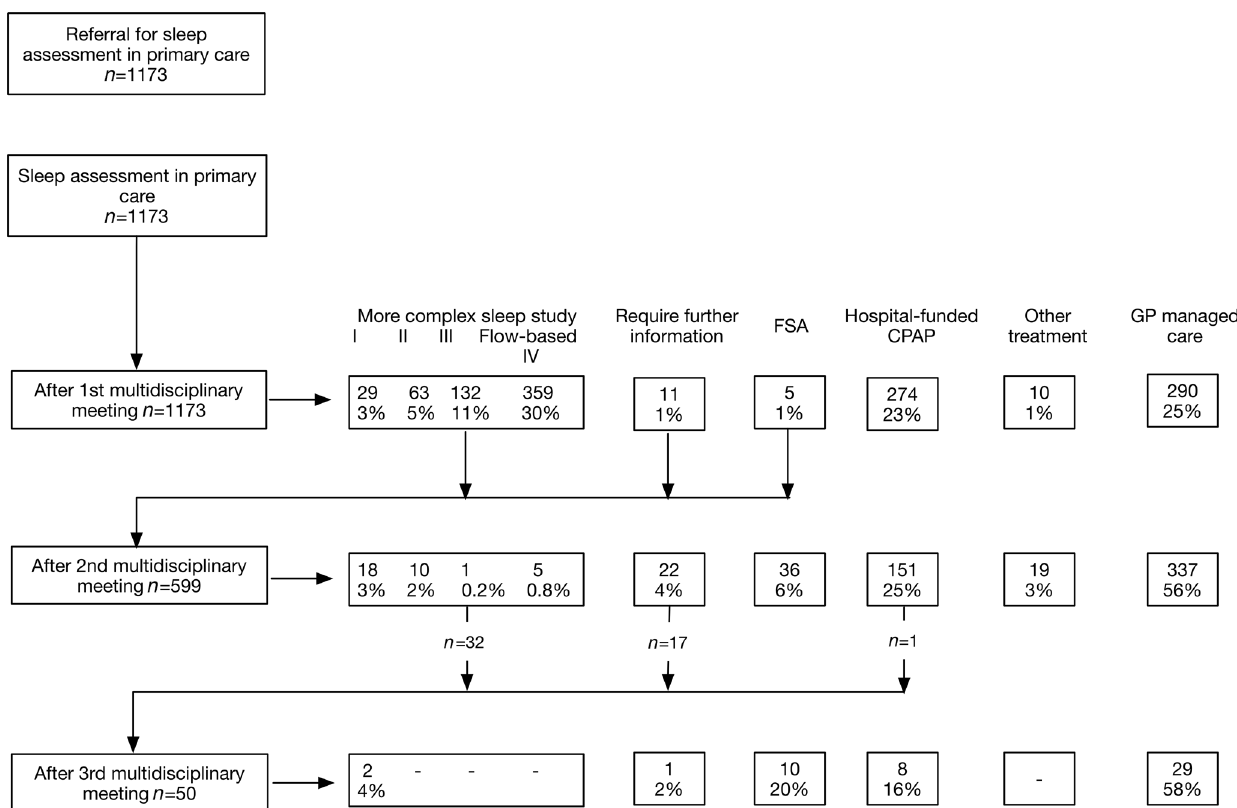
Fig. 3 The numbers of patients fl owing through the community assessment, MDM and treatment pathway during an example year, 2014